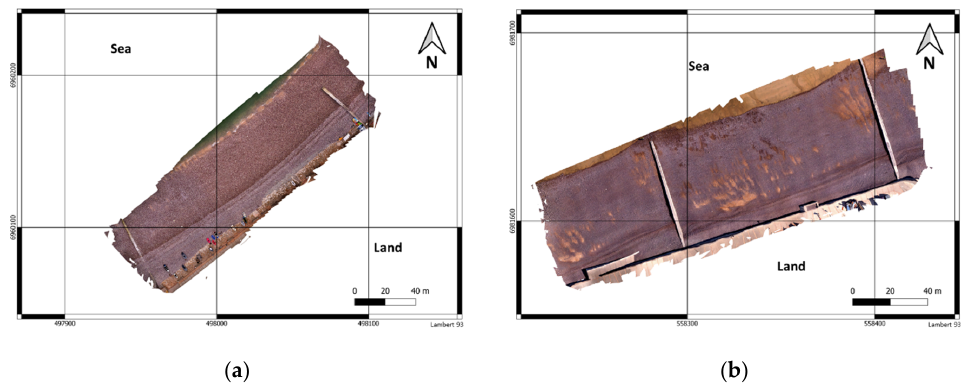
Figure 7. Unmanned Aerial Vehicle (UAV) derived Ortho-images of the pebble ridges at ( a ) Etretat and ( b ) Hautot-sur-Mer.